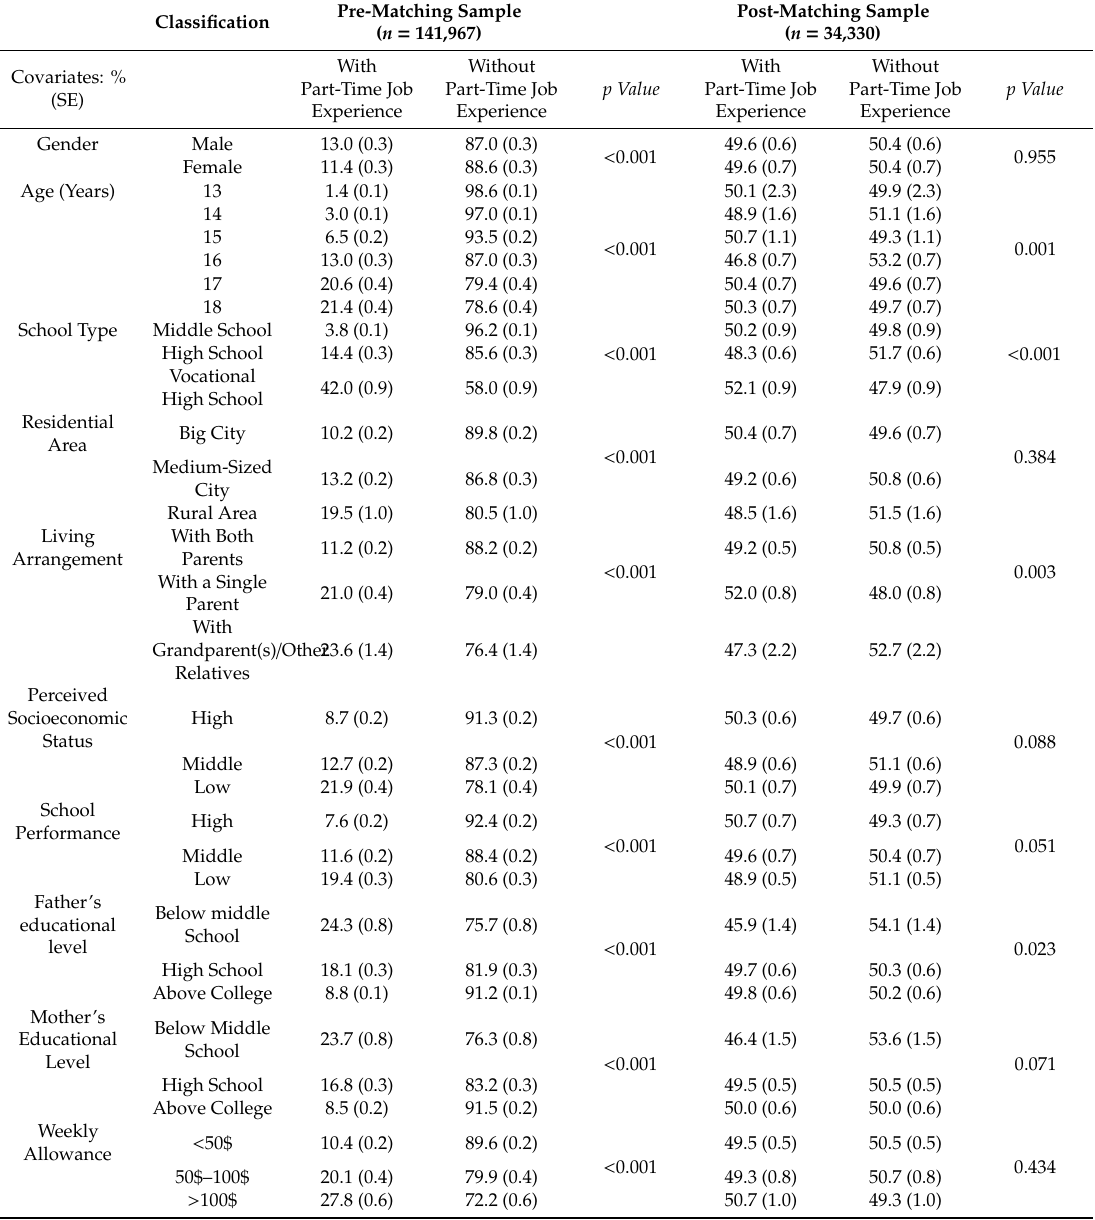
Table 2. Covariate imbalance before and after propensity score